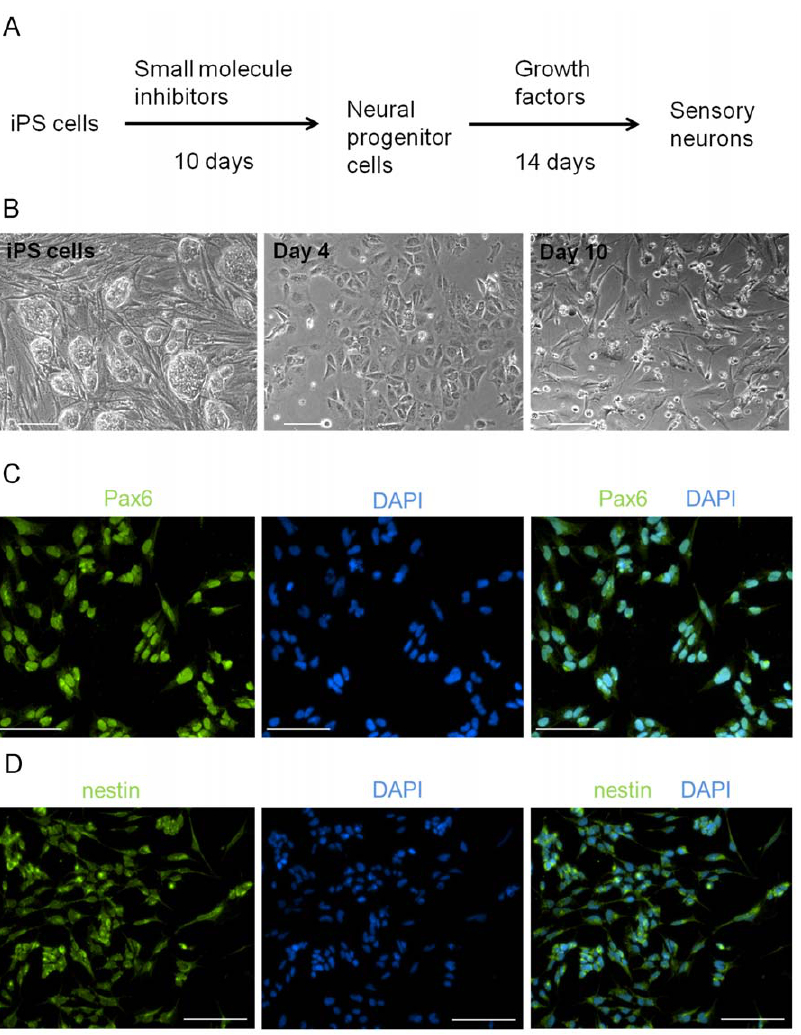
Figure 1. Conversion of human iPS cells to neural progenitor cells. (A) Outline of the differentiation protocol. Human iPS cells were dissociated and plated on Matrigel-coated plates. For the first 10 days, they were exposed to small molecule inhibitors, followed by culturing for two weeks in growth factors. (B) Brightfield images of iPS cells after 4 and 10 days of exposure to small molecule inhibitors. After 10 days, iPS cells expressed (C) Pax6 and (D) nestin, markers of neural progenitor cells. Nuclei were visualized with DAPI. Scale for all images is 100